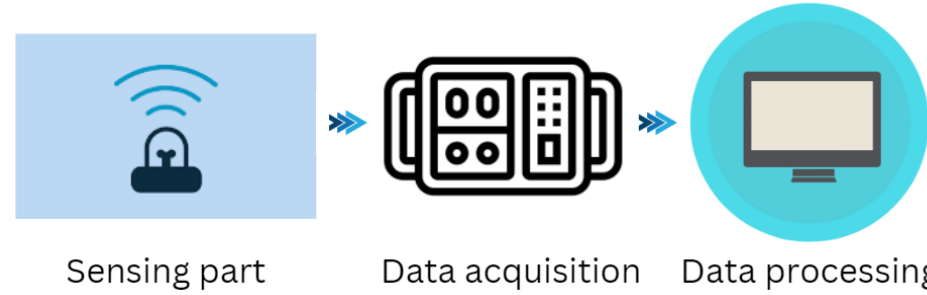
Figure 2. Scheme of a corrosion monitoring system.